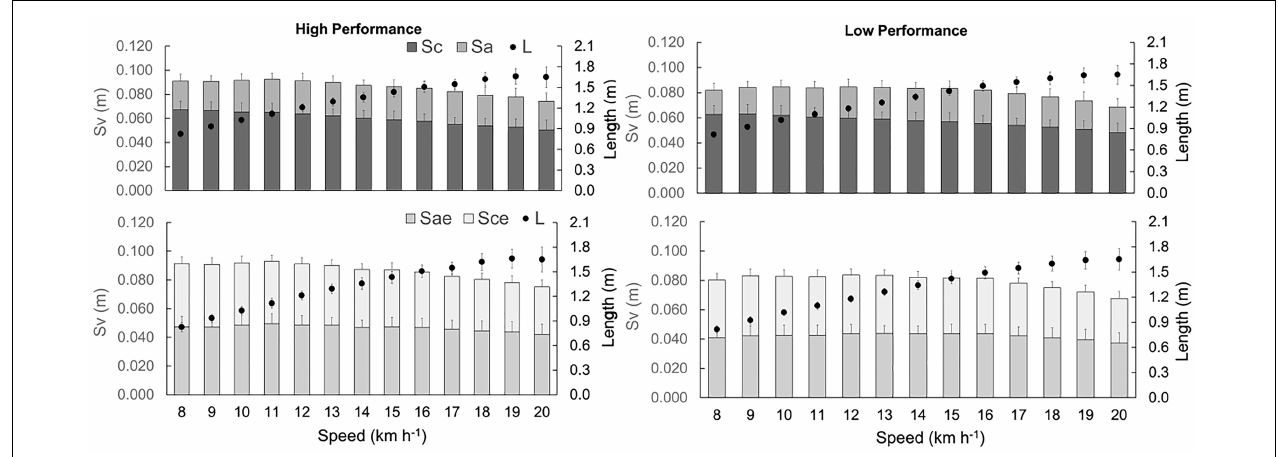
FIGURE 5 | Vertical displacements of BCoM ( S v ) during contact time ( S c ), aerial time ( S a ), effective aerial time ( S ae ), effective contact time ( S ae ), and step length ( L ). The gray bars are related to the left axis and the black circles to the right